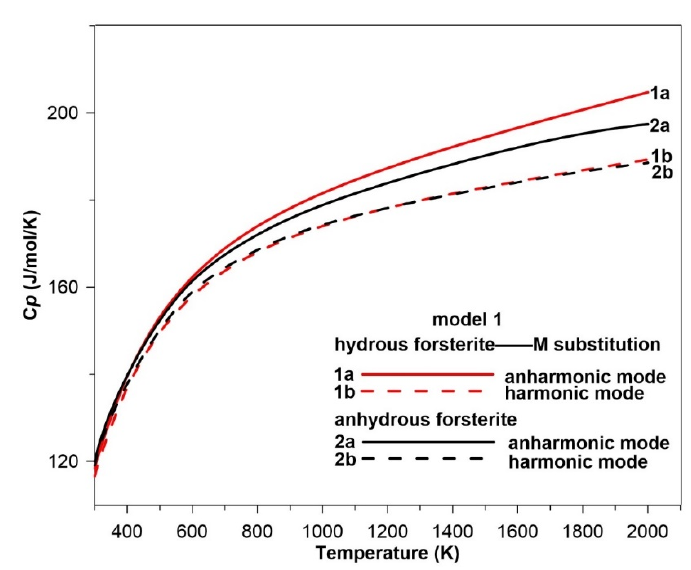
Figure 11. Comparison of the isobaric heat capacities for both the anhydrous and hydrous forsterite samples.